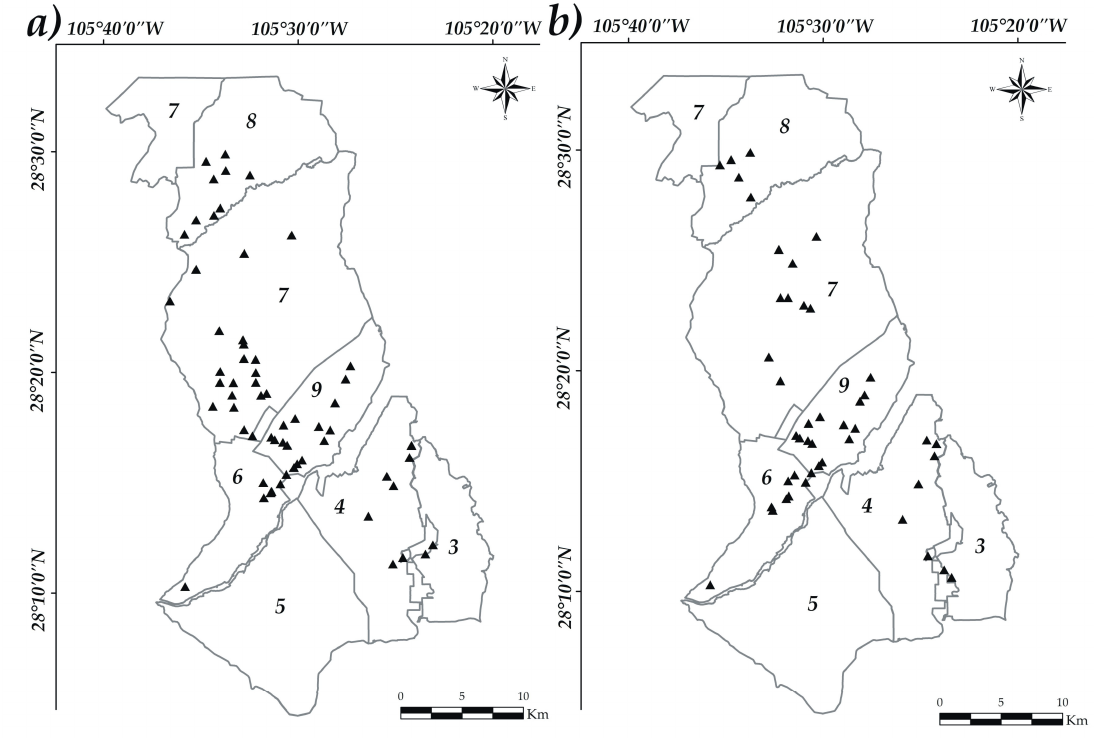
Figure 2. Sampling maps: ( a ) Summer (Sampling 1— left ) and ( b ) Fall (Sampling 2— right ). Studied modules ( — ), sampling points ( ), bold numbers denote the module number.